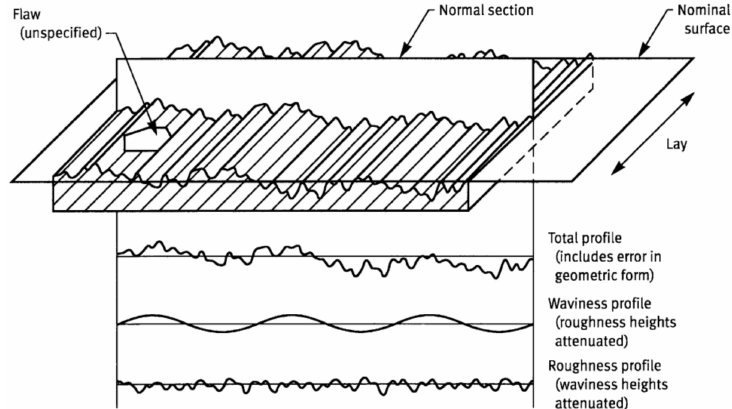
Figure 7. The approach to estimate bed surface roughness from the reconstructed bed surface models: along a normal section, surfaces can be decomposed to high frequency (roughness) and medium frequency (waviness) sinusoidal waves (or even lower frequency ones to get the surface form, not shown in the figure).